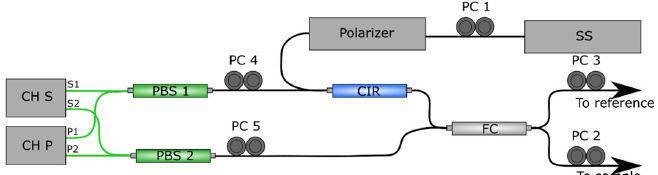
Figure 1. Schematic of the fiber-based setup PSOCT-1300 adapted from the manufacturer’s manual. Components are: balanced detectors (CH S and CH P), circulator (CIR), fiber coupler (FC), swept laser source (SS), manual fiber polarization controllers (PC numbered 1 to 5). Black lines indicate single-mode optical fiber (SMF), green lines indicate polarization-maintaining optical fiber (PMF).